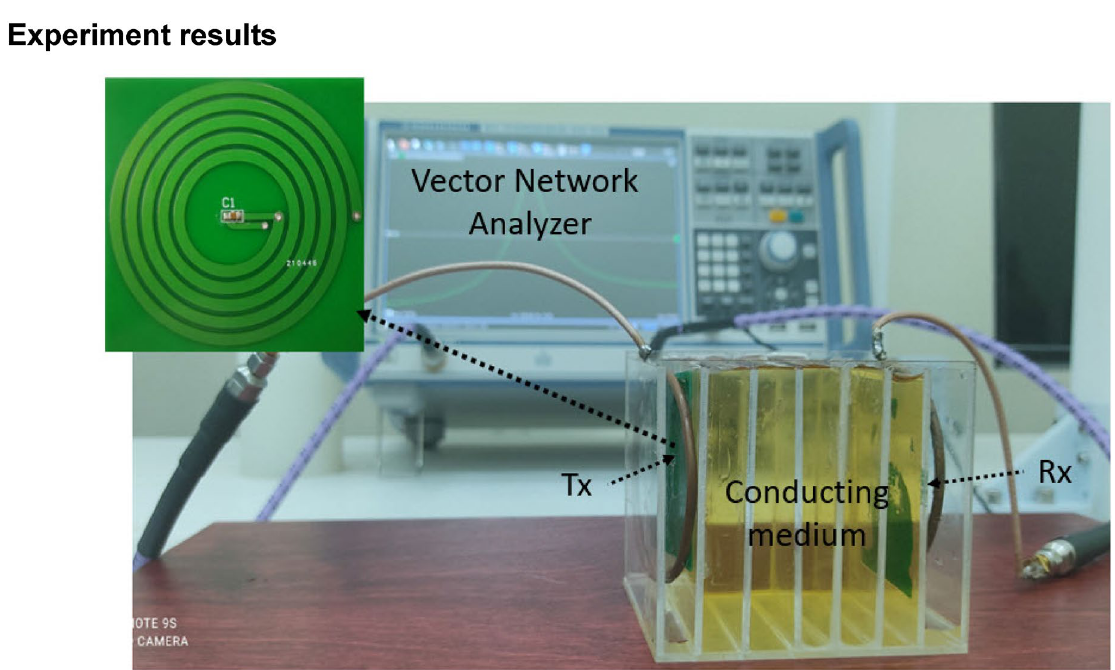
Figure 6. Experimental setup for MR-WPT in conducting